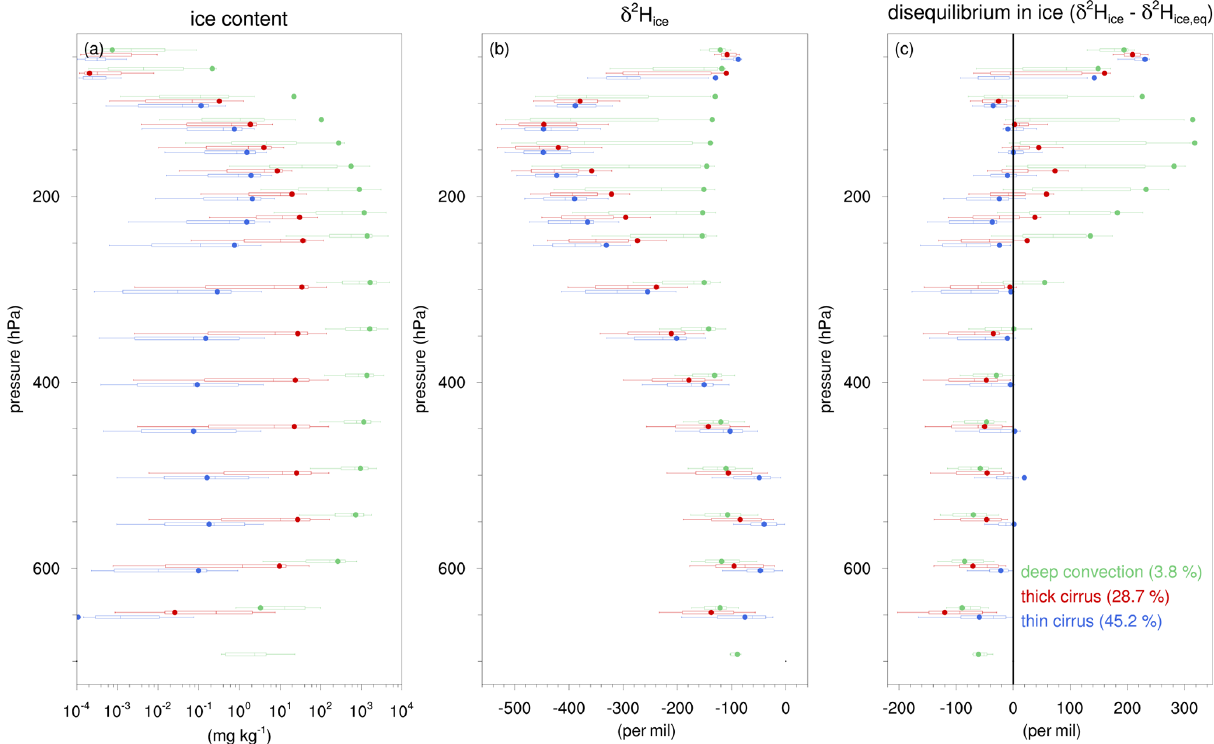
Figure 13. The statistical distribution and averages of ice and its isotopic composition for the 50–700hPa pressure range in the region of interest in July 2016. Boxes and whiskers indicate the 10th, 25th, median, 75th, and 90th percentiles and dots represent the averages of the (a) ice content (mgkg − 1 ), (b) δ 2 H in ice (‰), and (c) disequilibrium in ice (‰) for the ice cloud regimes, as indicated by the legend. The numbers in the text indicate the fractions of grid points in each ice cloud regime. The statistical distribution is based on grid points with an ice content ≥ 10 − 4 mgkg − 1 , whereas the averages are based on all grid points within the region of interest for the respective ice cloud